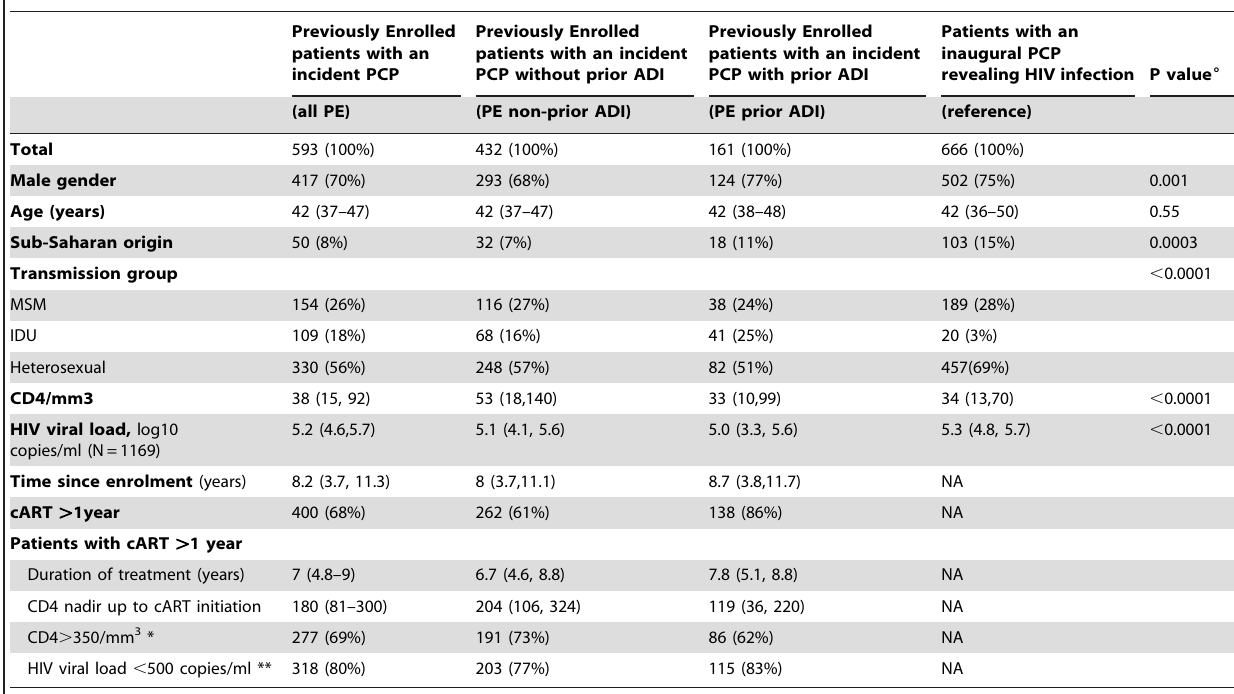
Table 1. Patients with a first episode of PCP in 2004–2011: characteristics at PCP diagnosis.